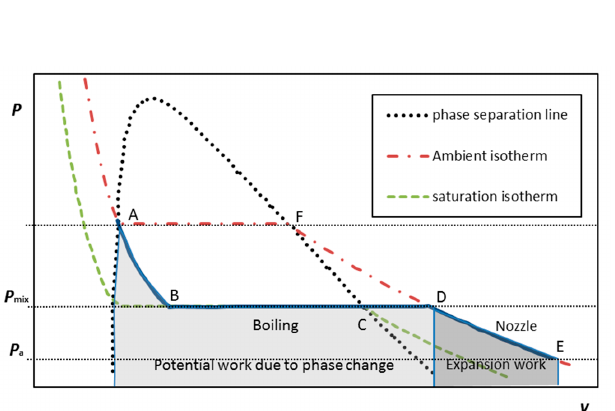
Figure 3. P–V diagram of an ideal simplified thermodynamic cycle of a multiphase ramjet employing boiling of liquefied gas as a source of bubbles. The area under the ABCD line reflects a potential ideal additional work due to phase change of the liquefied gas (LG). The area under DE is the expansion work in the nozzle.